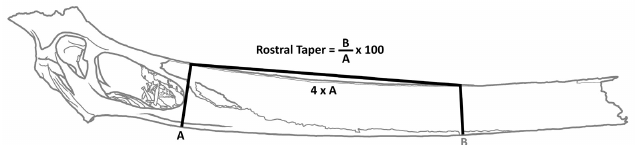
Figure 8. Method for measuring percent rostral taper, calculated as the percent reduction in rostral height from the rostral base (measured at the anterior extent of the na- soantorbital fenestra where possible, or at the most basal preserved portion of incomplete rostra) to a distance four times that of the basal height.